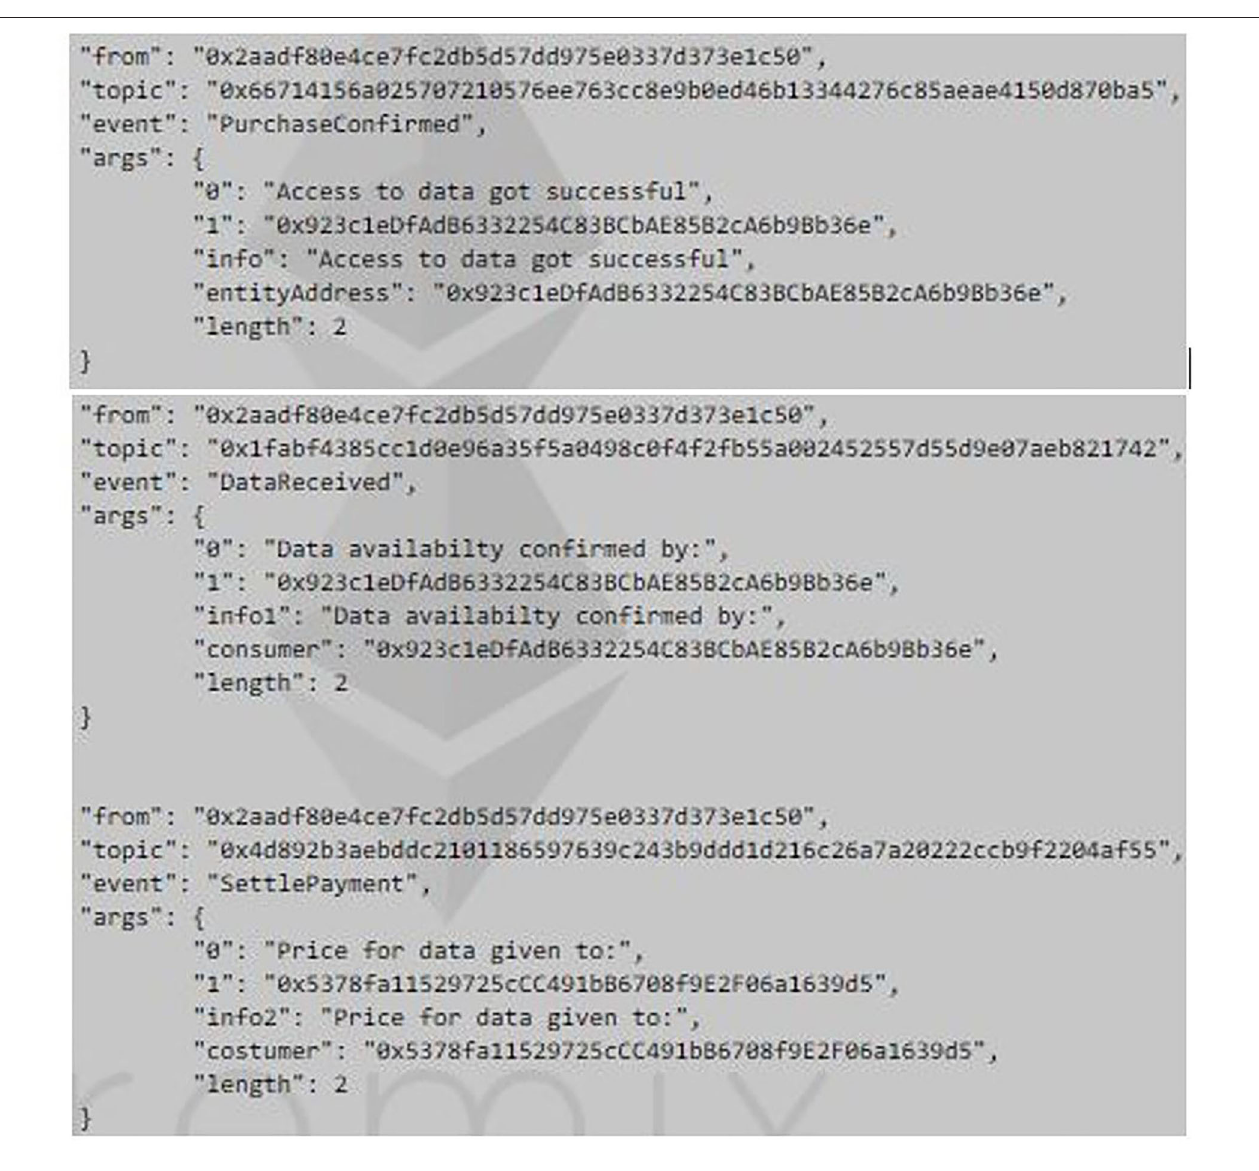
FIGURE 10 | Logs of successful transaction and payment.